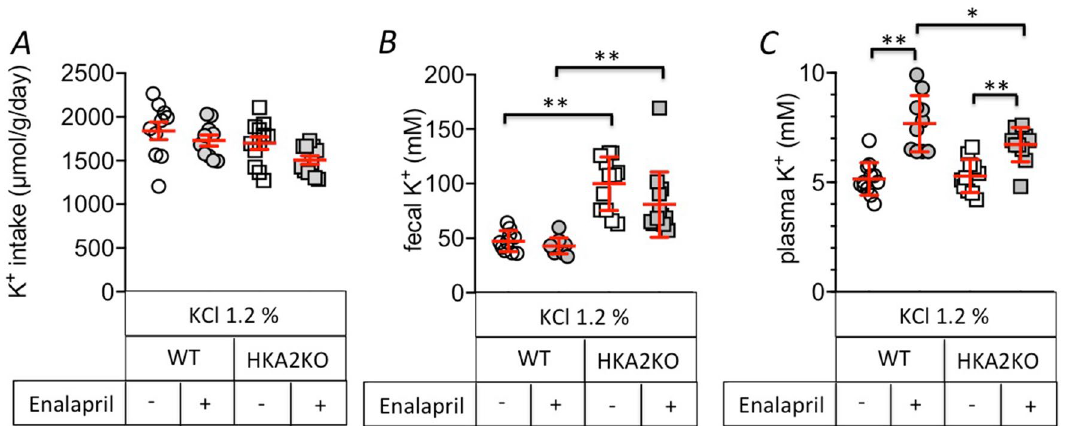
Figure 5. Enalapril-induced hyperkalemia is lowered in N5/6 HKA2KO mice. ( A ) Daily K + intake in N5/6 WT (circles) or HKA2KO (squares) mice after 24 h-K + loading treated (grey symbols) or not (white symbols) with enalapril (0.12 mg/ml) for a week. ( B ) Fecal K + excretion in N5/6 WT (circles) or HKA2KO (squares) mice after 24 h-K + loading, treated (grey symbols) or not (white symbols) with enalapril (0.12 mg/ml) for a week. ( C ) Plasma K + values in N5/6 WT (circles) or HKA2KO (squares) mice after 24 h-K + loading, treated (grey symbols) or not (white symbols) with enalapril (0.12 mg/ml) for a week. Results are shown as the mean ± s.e.m (n = 10). Two-way ANOVA test followed by a Sidak’s multiple comparisons test, (** p < 0.01; * p <